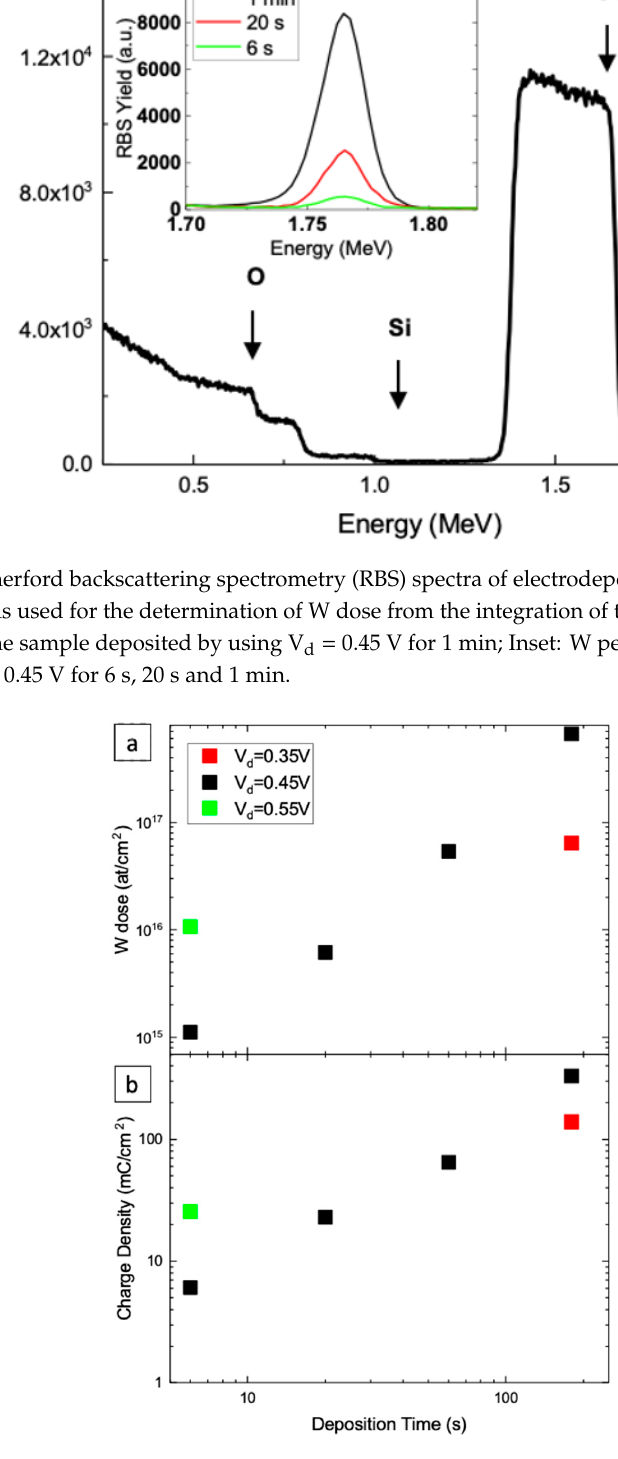
Figure 9. ( a ) W dose obtained from RBS spectra as a function of t d for different V d values; ( b ) charge density obtained from the integration of the current transient as a function of t d for different V d values.